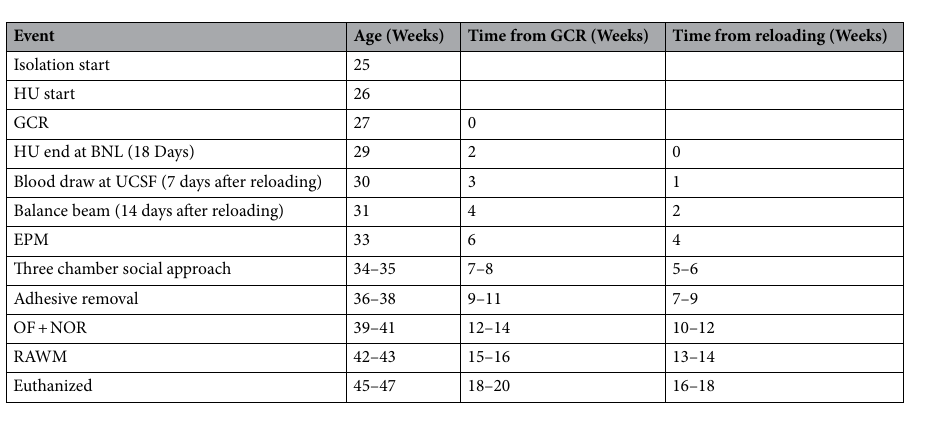
Table 1. Animal ages and time elapsed during